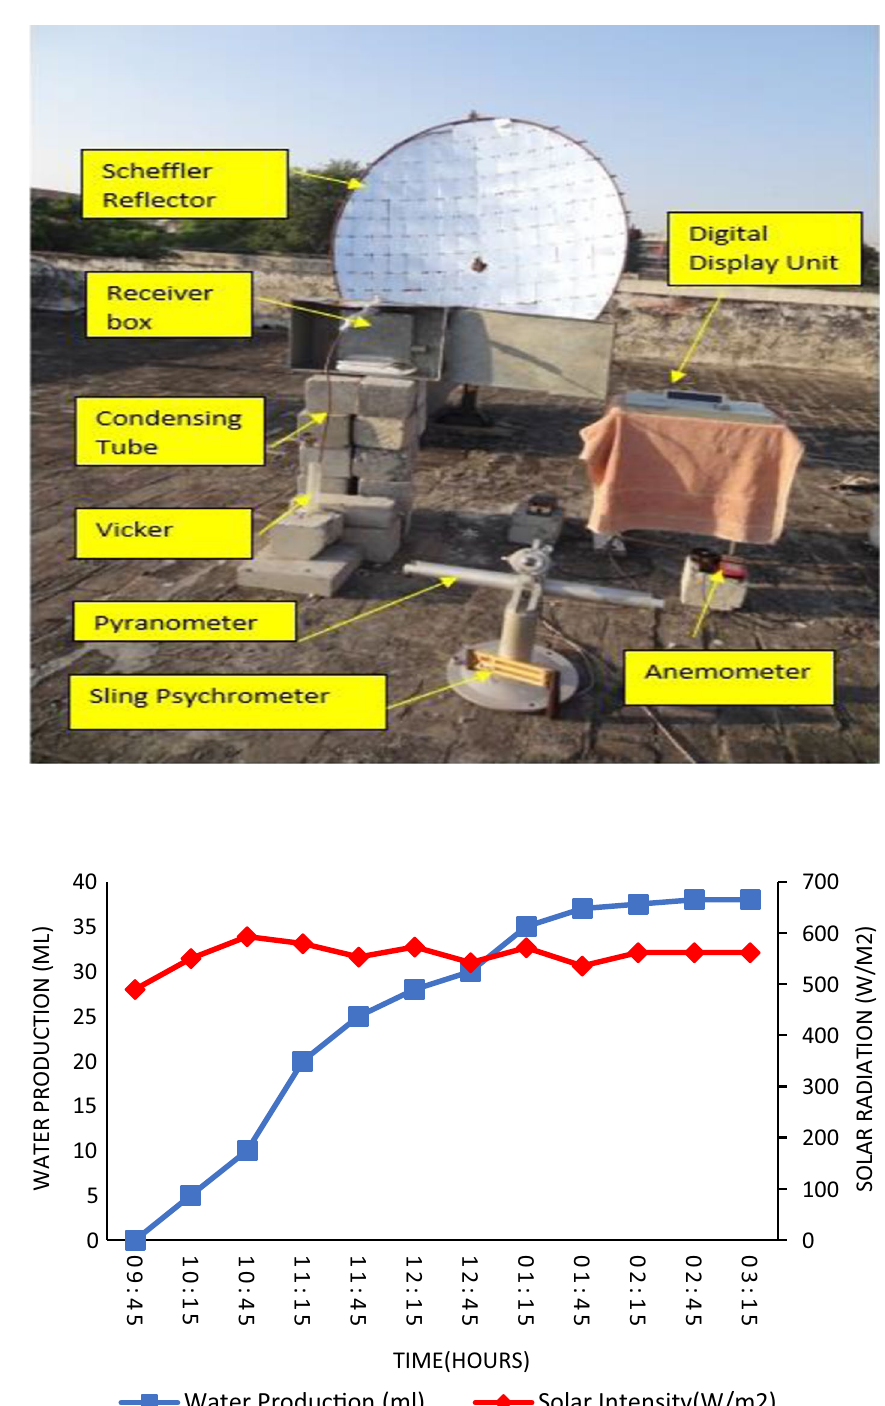
Fig. 2 Pictorial view of experi- mental setup